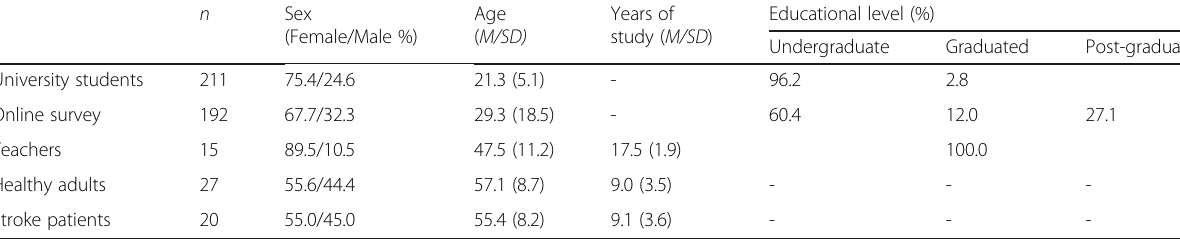
Table 1 Demographic characteristics of the five studied